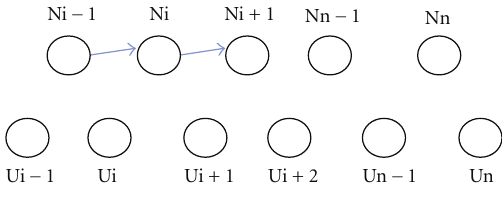
Figure 1: Triple umpiring